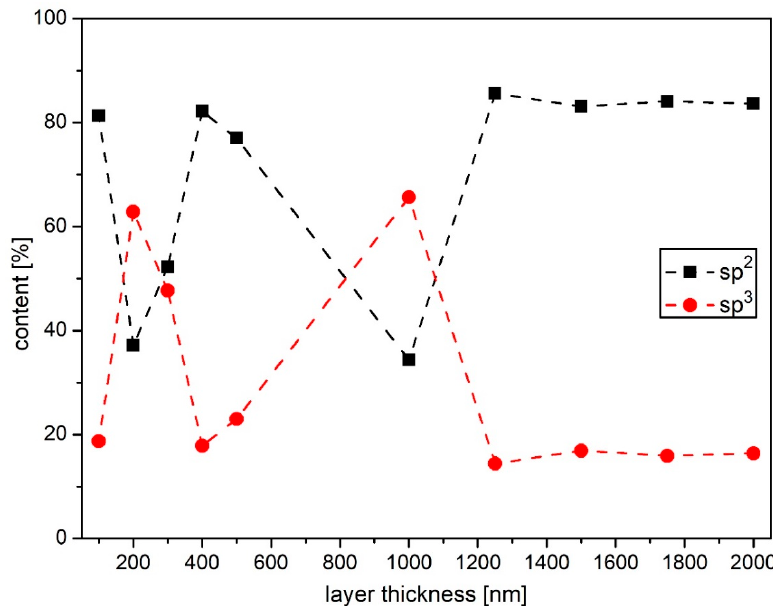
Figure 6. XPS results for thick a-C:H layers deposited on PC, up to 2000 nm. The black squares are the sp 2 content and the red circles are the sp 3 bound carbons plotted against layer thickness (dashed lines only show a trend).